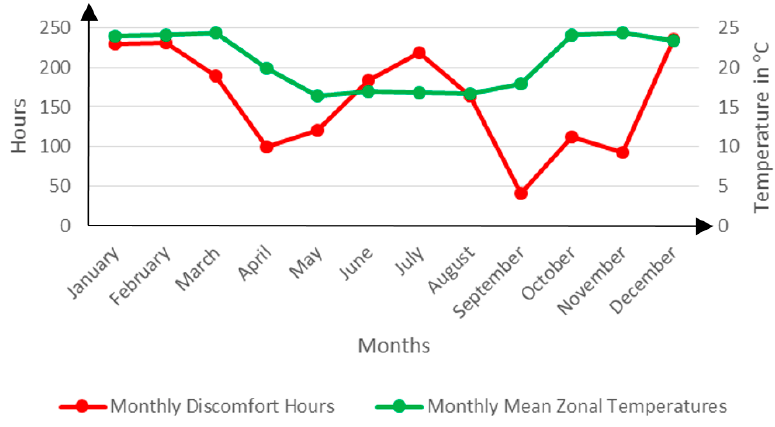
Figure 20. Monthly mean zonal temperatures and discomfort hours for Case